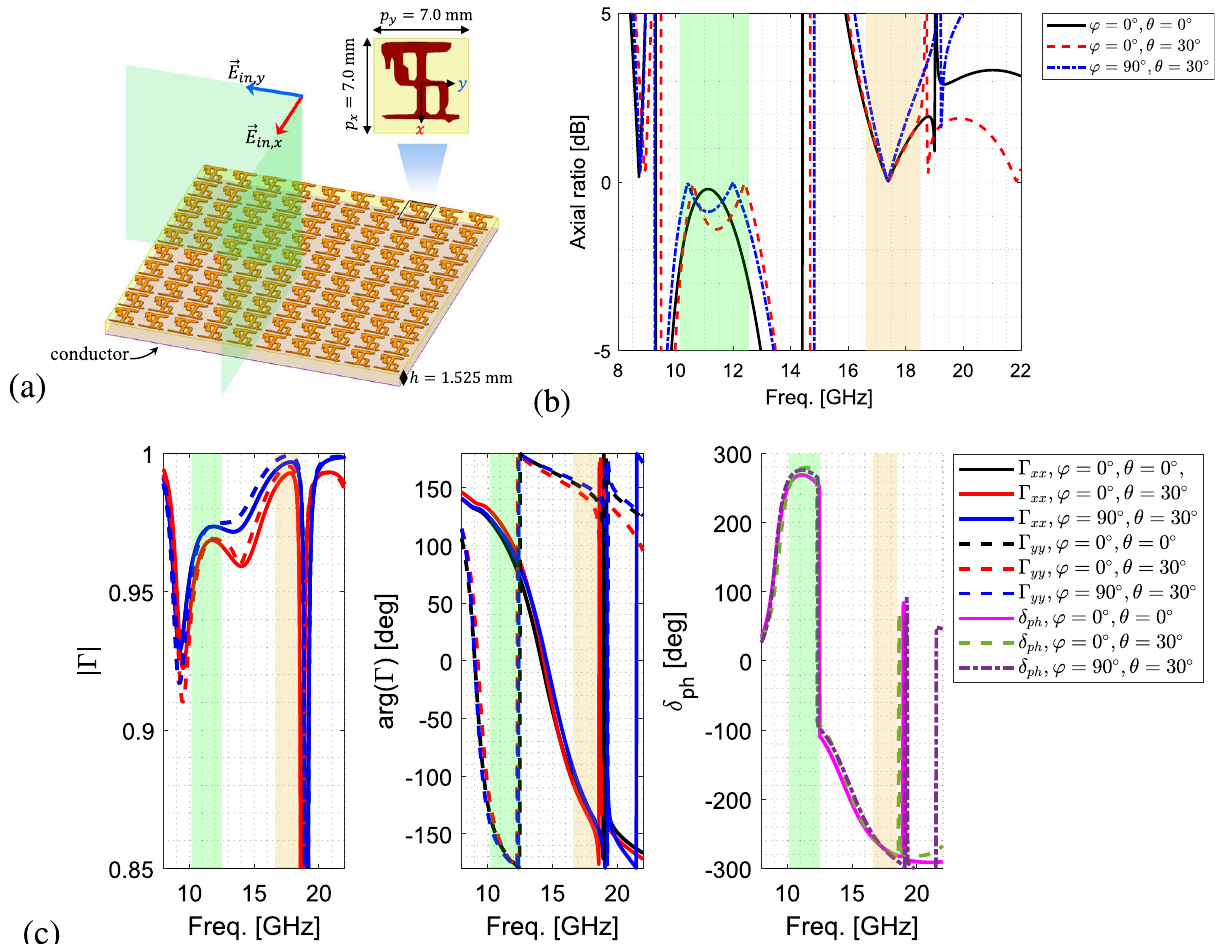
Figure 5. ( a ) The structure of optimized dual-band reflective polarizer. ( b ) The axial ratio, ( c ) the amplitude, phase and phase difference, δ ph , of the linear-polarized reflection coefficients Ŵ xx and Ŵ yy of the optimized dual- band polarizer for normal and oblique incidence at θ = 30 dB values of AR represent the switch in the handedness of the CP